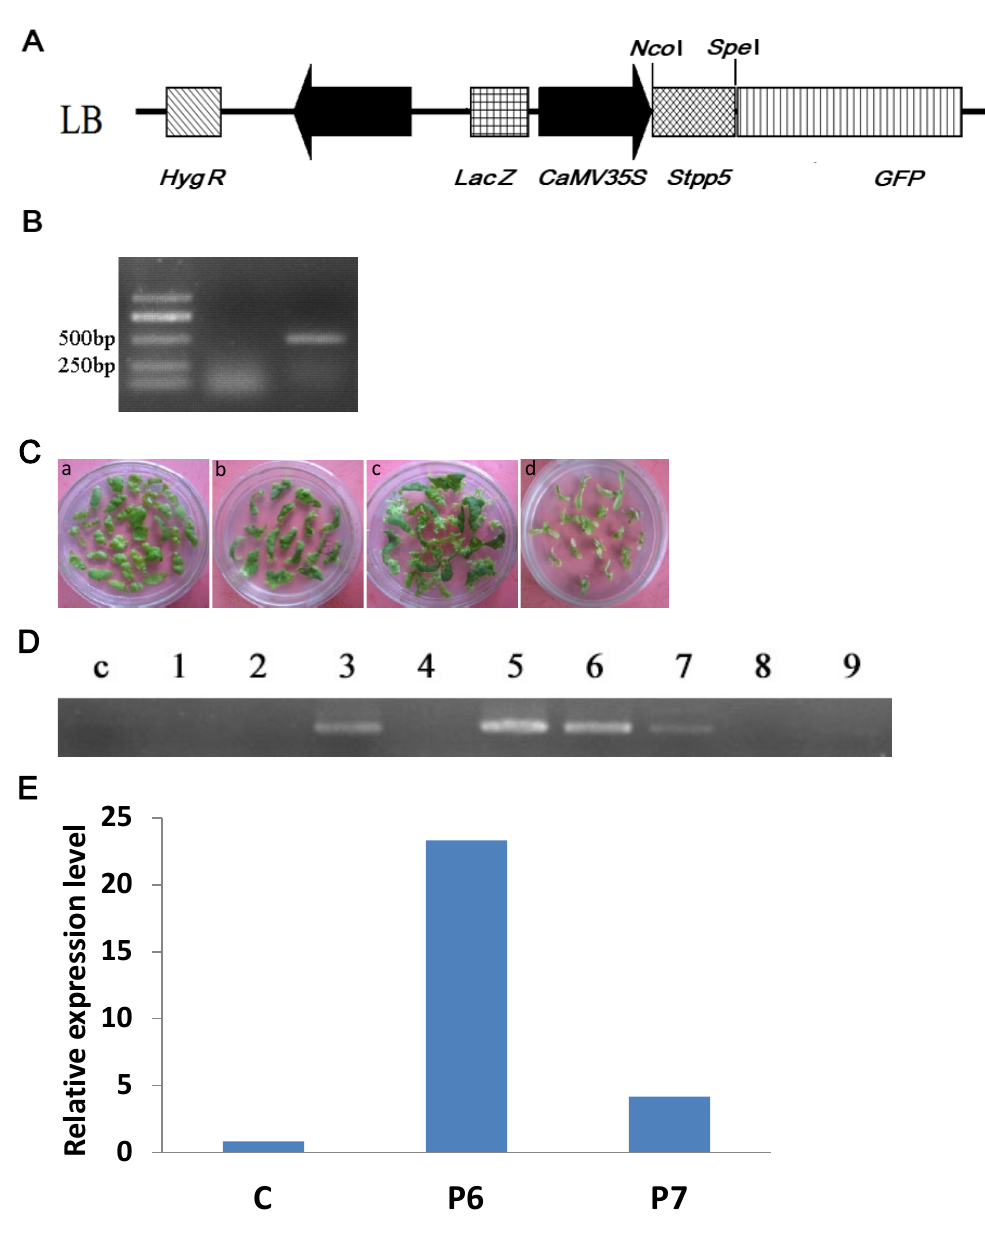
Figure 6. Genetic transformation and regeneration of transgenic StPP5 tobacco plants: ( A ) Schematic representation of the binary vector pCMBIA1304- StPP5 : LB, T-DNA left border; Hyg R , hygromycin resistance; lacZ , lacZ lapha; CaMV 35S, promoter; GFP , green fluorescent protein gene; nos, Nos(nopaline synthase) polyA signal, terminator; RB, T-DNA right border; ( B ) PCR identification of pCAMBIA1304- StPP5 recombinant plasmid in transformed A. tumefaciens : M, Marker; c, non- transformed control; cz, recombinant plasmid pCAMBIA1304- StPP5 ; ( C ) regeneration of transgenic tobacco plants: a, Explants; b, adventitious bud formation; c, the roots selection of 25 mg/L Hyg B; d, transgenic tobacco regeneration; ( D ) identification of StPP5 transgenic tobacco lines by PCR; ( E ) RT-qPCR analysis of StPP5 expression in transgenic tobacco lines: c, non-transgenic plant; P6 and P7, transgenic